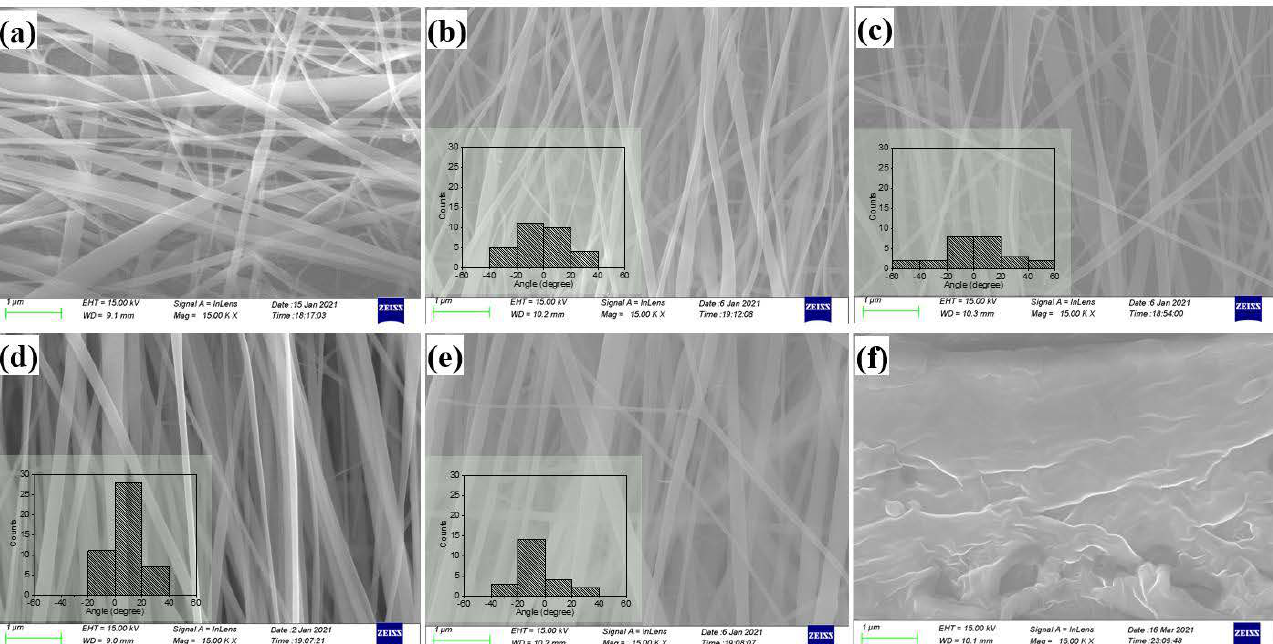
Figure 2. SEM images of the random oriented nanofibers ( a ) and nanofibers electrospun with a collector speed of 1000 rpm ( b ), 1500 rpm ( c ), 1700 rpm ( d ) and 2500 rpm ( e ) and cross-sectional of the PVDF film ( f ). Insets in ( b – e ) are orientation distribution statistics of the nanofibers.